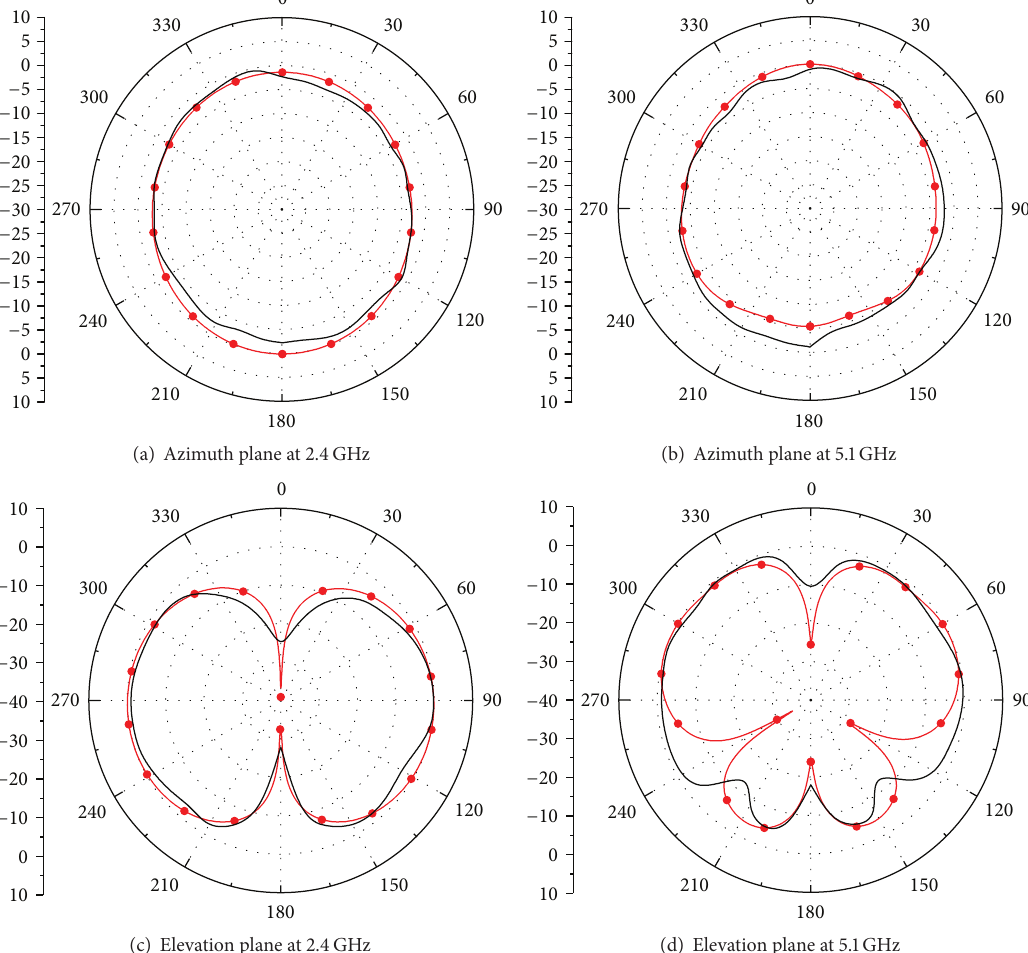
Figure 14: Optically controlled reconfigurable filtenna radiation pattern: simulation (red curves with circles) and measurements (black continuous